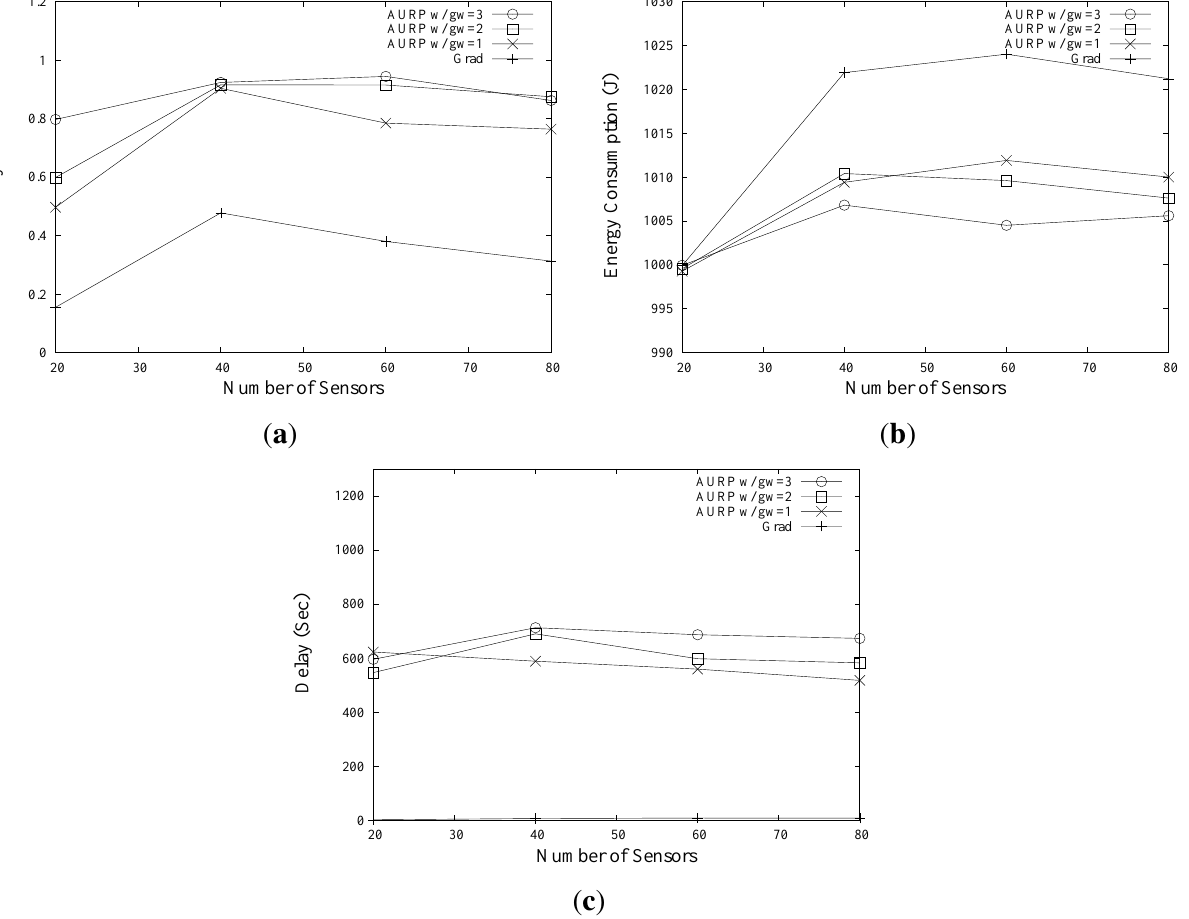
Figure 5. Effects of number of U-sensors on the network